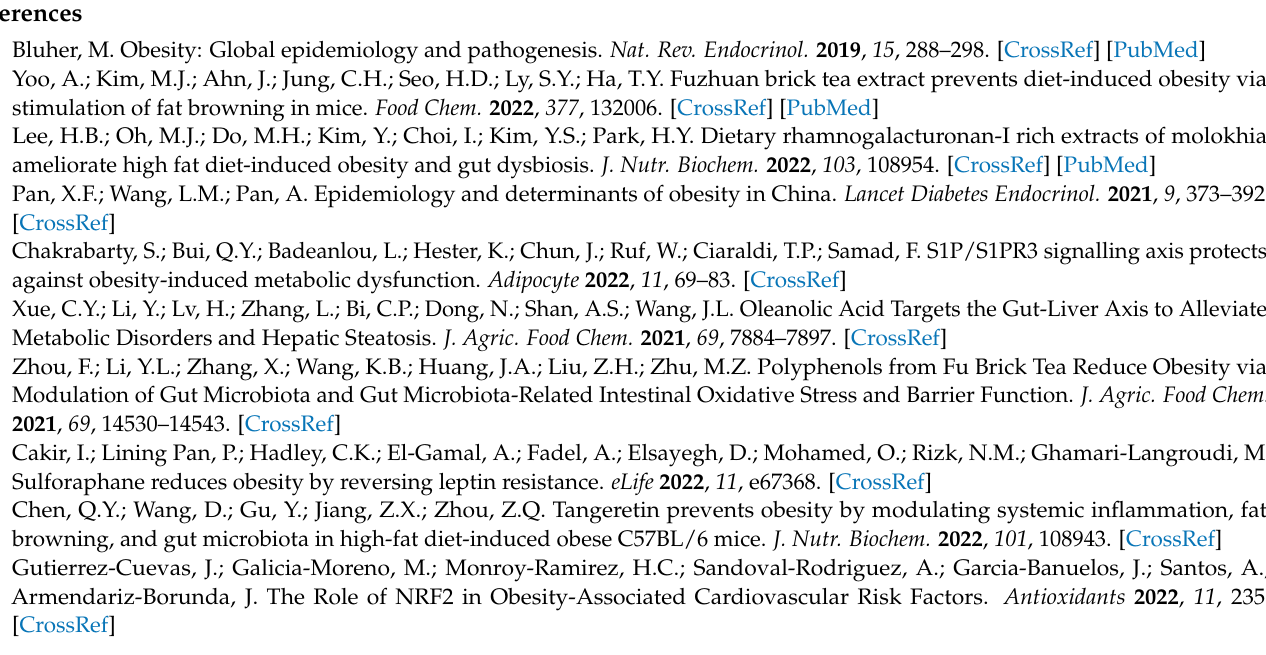
nents; Figure S2: H&E staining of heart, spleen, and kidney of mice; Table S1: Details of antibodies HFD-fed mice and IH-treated HFD-fed mice; Table S3: The differential metabolic pathways